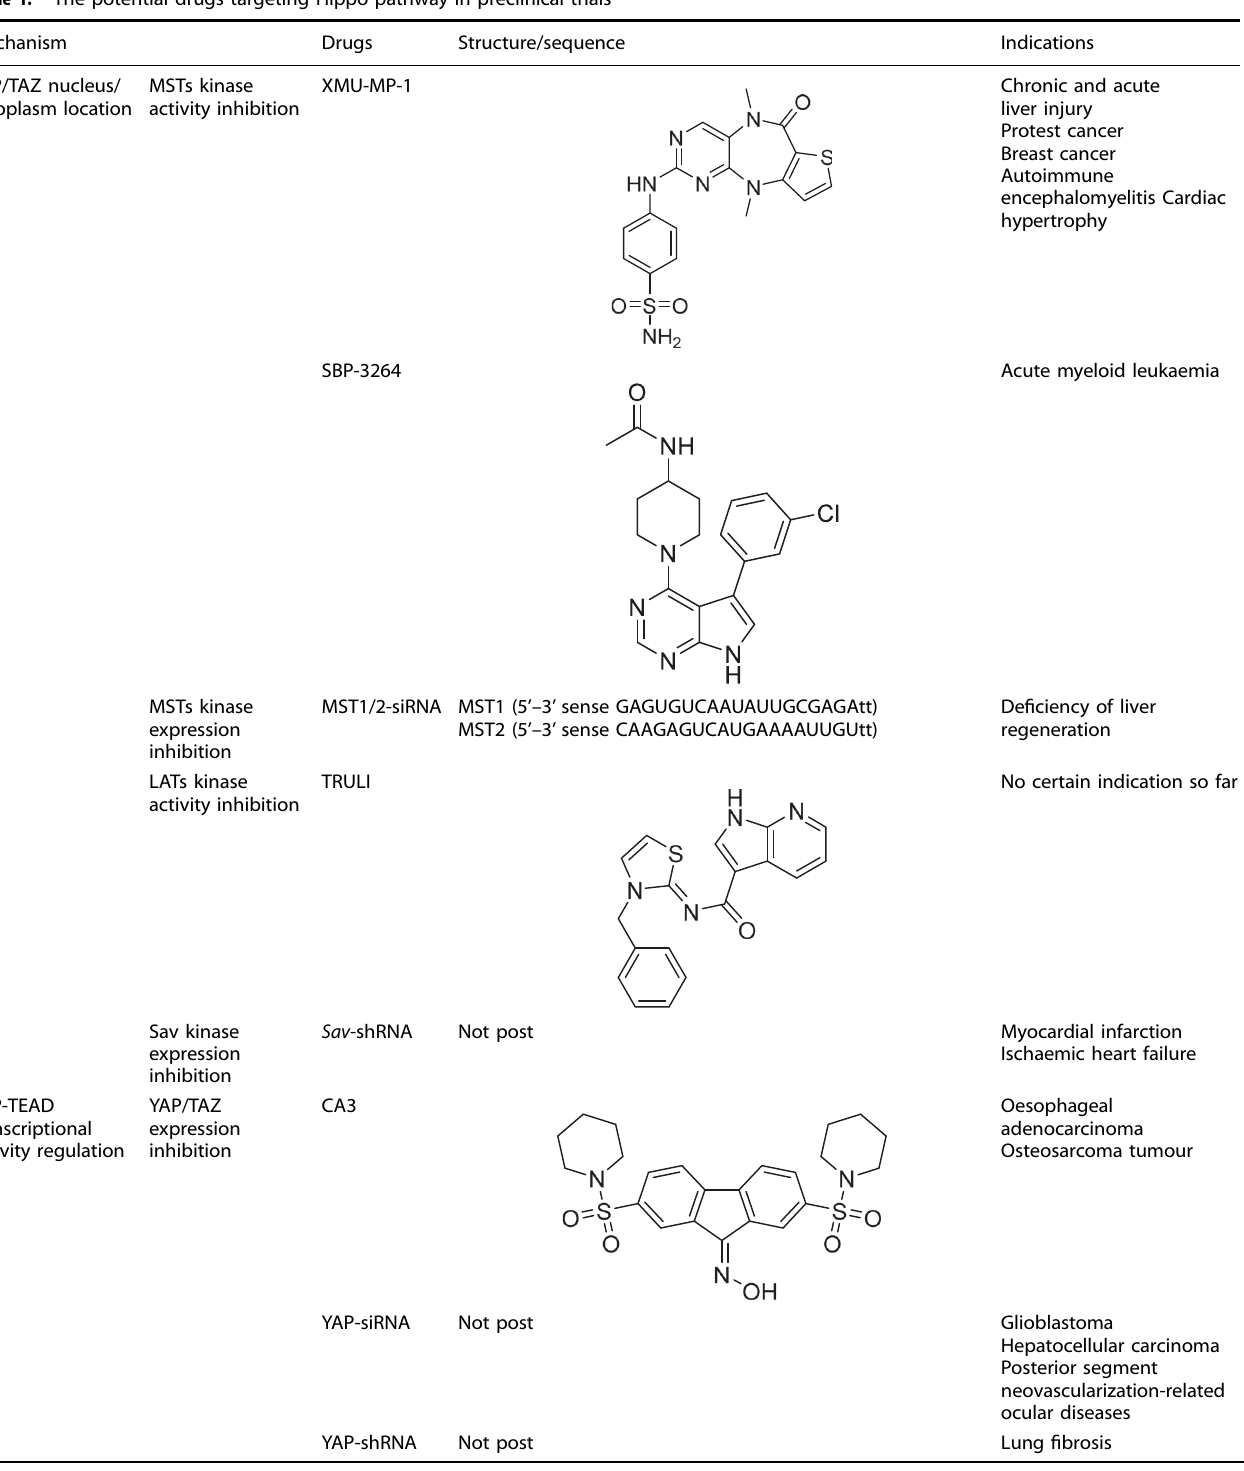
Table 1. The potential drugs targeting Hippo pathway in preclinical trials Mechanism Drugs Structure/sequence